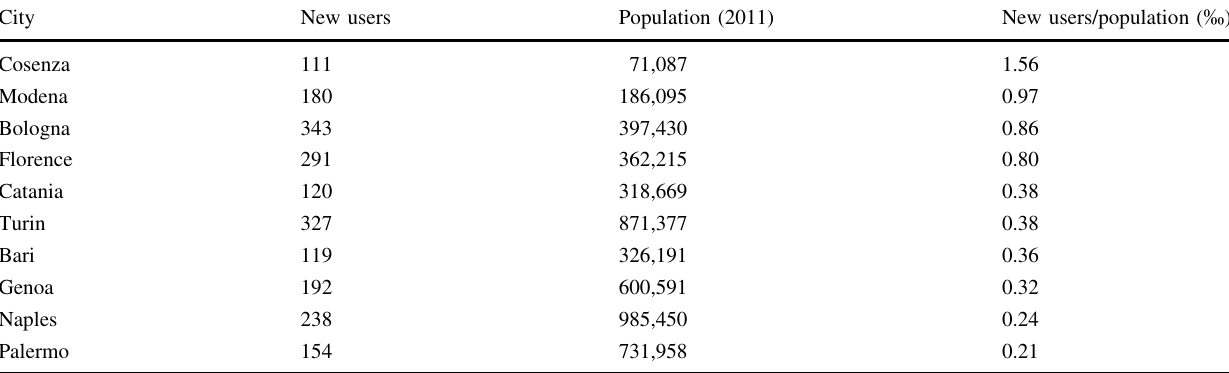
Table 4 #italiasicura data on the number of new users for a selected number of Italian cities, compared with their population in the period 14 April 2015–13 December 2015